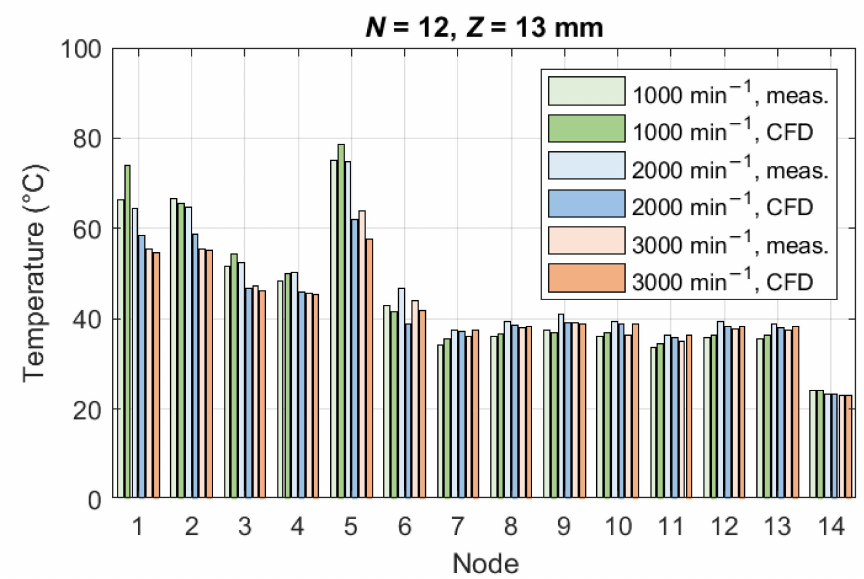
Figure 9. Temperature distribution for N = 12 and Z = 13 mm at different